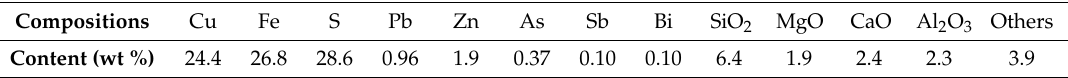
Table 1. Compositions of the mixed concentrates into the furnace.